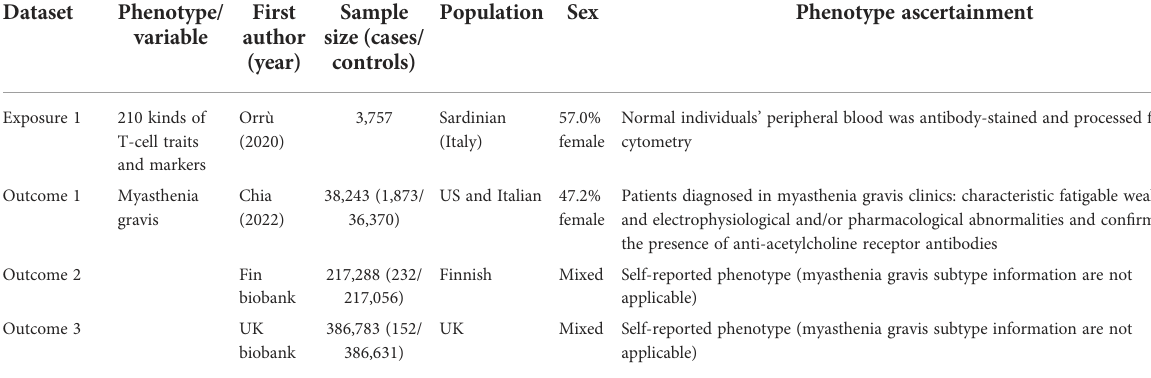
TABLE 1 GWAS datasets used in this Mendelian randomization (MR) study.